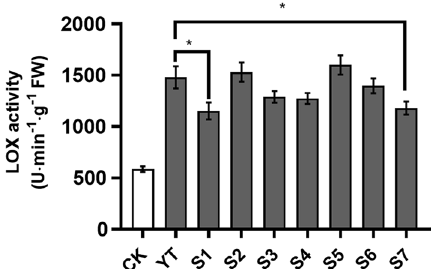
Fig. 5 LOX activities in rice plants treated with mechanical wounding and individual bacterial strains isolated from oral secretion of SSB larvae. Values are means SEM (n 10). CK, untreated rice plants. ± = Asterisks indicate significant differences between YT media treatment and individual bacterial isolates treatment (unpaired t -test; YT vs. S1 ( Acinetobacter ), t 2.395, df 18, P 0.0277; YT vs. S7 ( Enterobacter ), = = = t 7.967, df 18, P < 0.001) = =